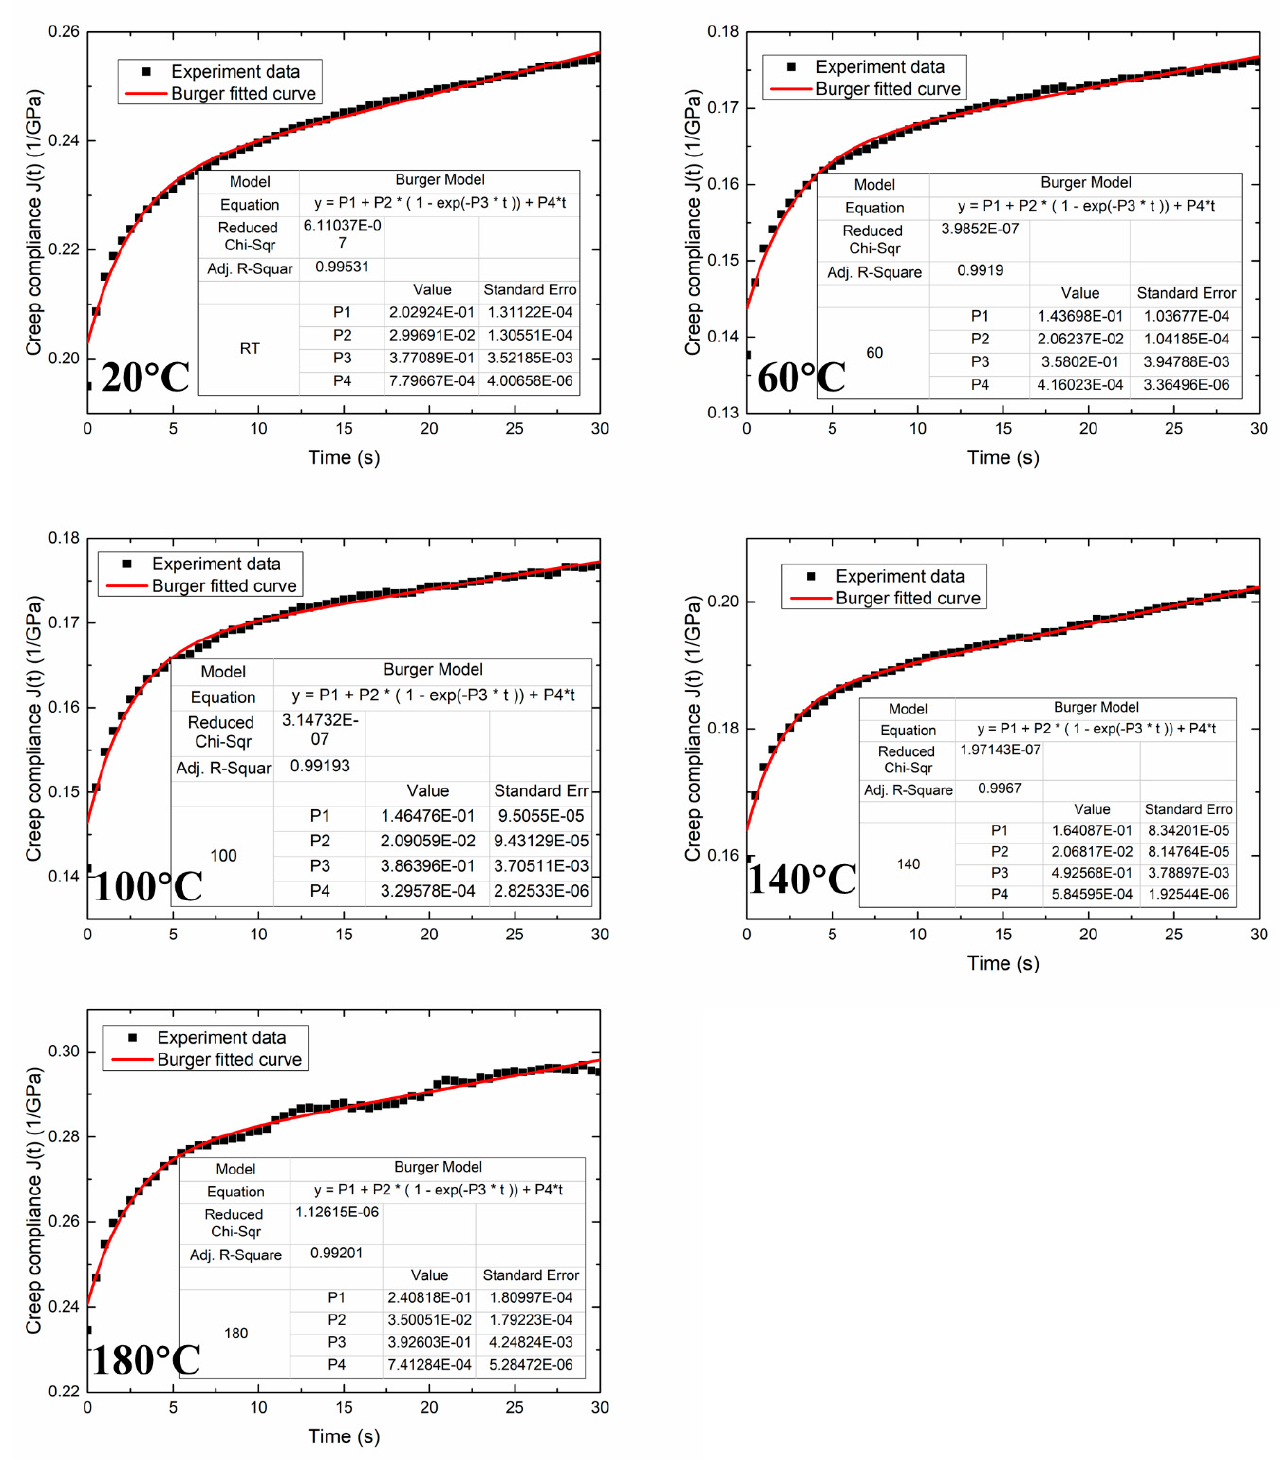
Figure 9. The test data and simulated curves of H2 heat-treated wood cell wall. Table 1. Parameters of Burgers model.